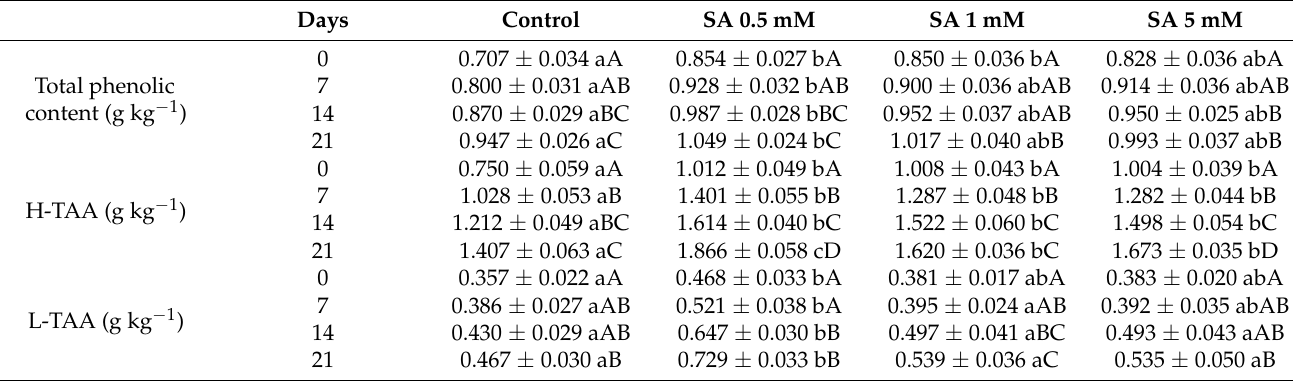
1 Values (mean of three replicates) ± SE followed by different lowercase letters, within the same row, show significant differences ( p < 0.05) among treatments, according to Tukey’s HSD test, for each parameter. Different capital letters in the same column show significant differences among storage days for each treatment at p <